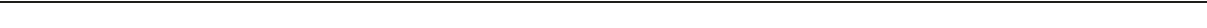
Fig. 3 Oxidation-sensitive p62 is required for pro-survival autophagy. a p62 − / − MEFs stably expressing FLAG-tagged wild type or C105A,C113A p62 were treated with cycloheximide (CHX, 50 μ g/ml) and H 2 O 2 (1 mM), either in the absence ( a ) or presence ( b ) of ba fi lomycin A1 (Baf, 50 nM), lysed at the indicated time post treatment, immunoblotted for p62 and quanti fi ed. c Cells described in a plus one stably expressing K7A,D69A PB1-domain mutant of p62 were treated with H 2 O 2 (1 mM, 5 h), lysed and immunoblotted for ubiquitin, LC3, p62 and actin ( c ) and quanti fi ed ( d ). e , f Stable p62 cell lines in control conditions were fi xed and stained for p62 and LC3 ( e ) and the % cells with > 20 autophagosomes was quanti fi ed ( f ). g , h Electron microscopy of stable p62 cell lines. White arrows: autophagosomes; black arrows: autolysosomes; blue arrow: endosome. Scale bar: 500 nm ( g ). Autophagosomes were quanti fi ed and graphs represent average number and % cells with three or more autophagosomes per fi eld of view ( h ). i , j Stable p62 cell lines were treated as in c and % cell death was analysed by Ready Probes fl uorescent dyes ( i ). j Stable p62 cell lines were treated as indicated and % cell death was analysed as in i . Error bars represent s.e.m., n = 3 , * P < 0.05, ** P < 0.01, *** P < 0.005 (unpaired t -tests). NS not signi fi cant. Scale bar: 20 µ m (IF) and 500 nm